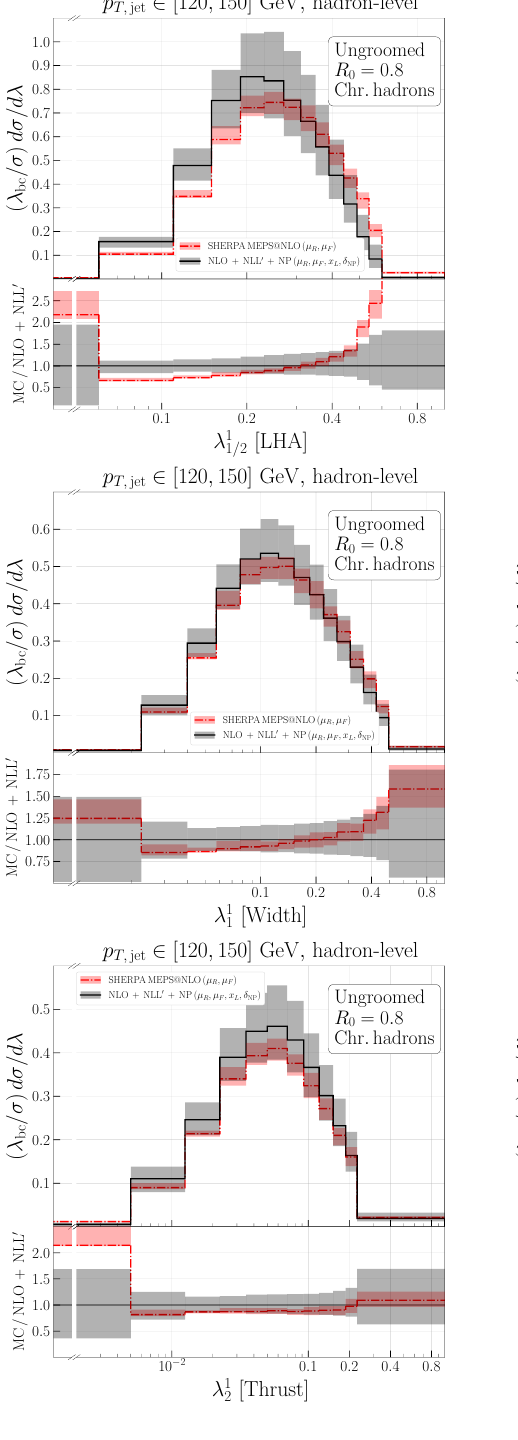
Figure 16 . Comparison of hadron-level predictions from S HERPA (MEPS@NLO), based on charged hadrons only, for ungroomed and groomed jet-angularities in Zj production, with p T, jet ∈ [120 , 150] GeV, with NLO + NLL 0 results corrected for non-perturbative effects. Here λ bc stands for the bin